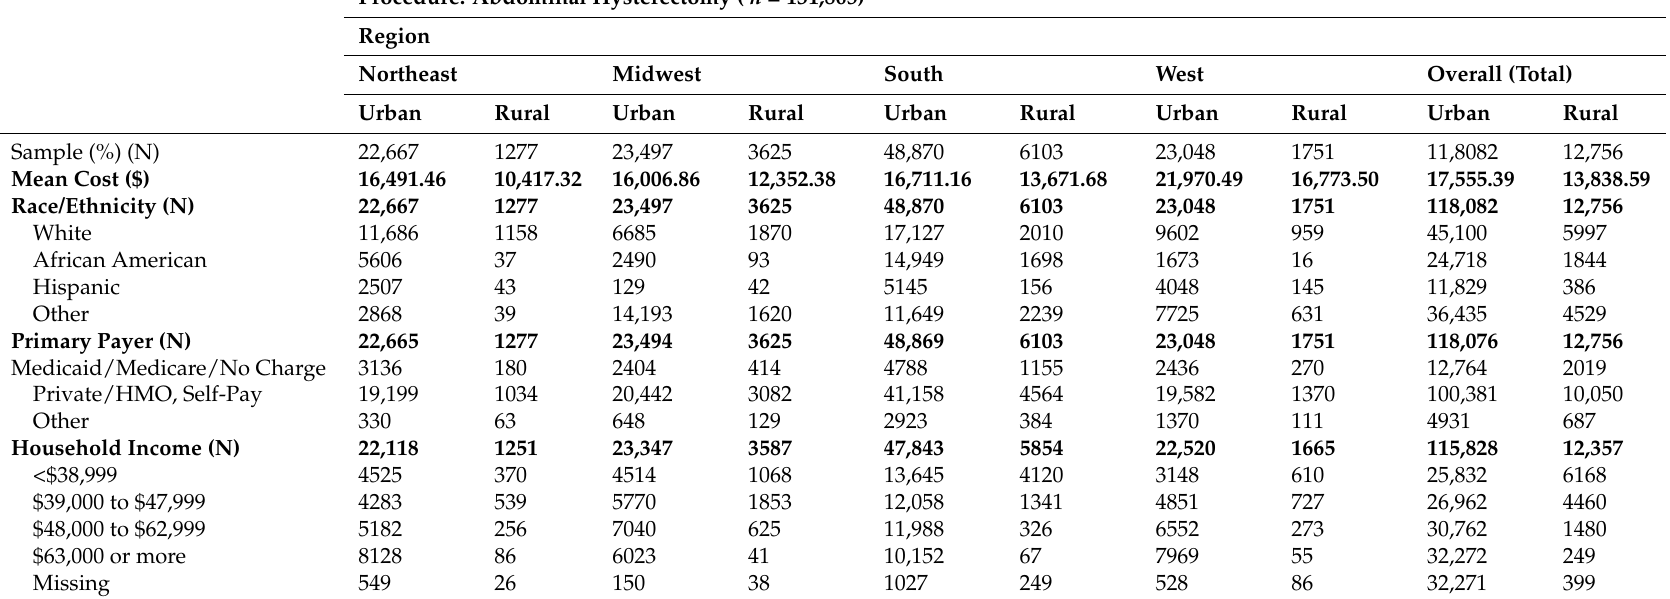
Table 2. Regional Distribution of Abdominal Hysterectomy (AHYS) by Cost, Length of Stay, Race/Ethnicity, Adverse Complications, Primary Payer, Household Income and Patient Referral Source in the United States between 2004 and